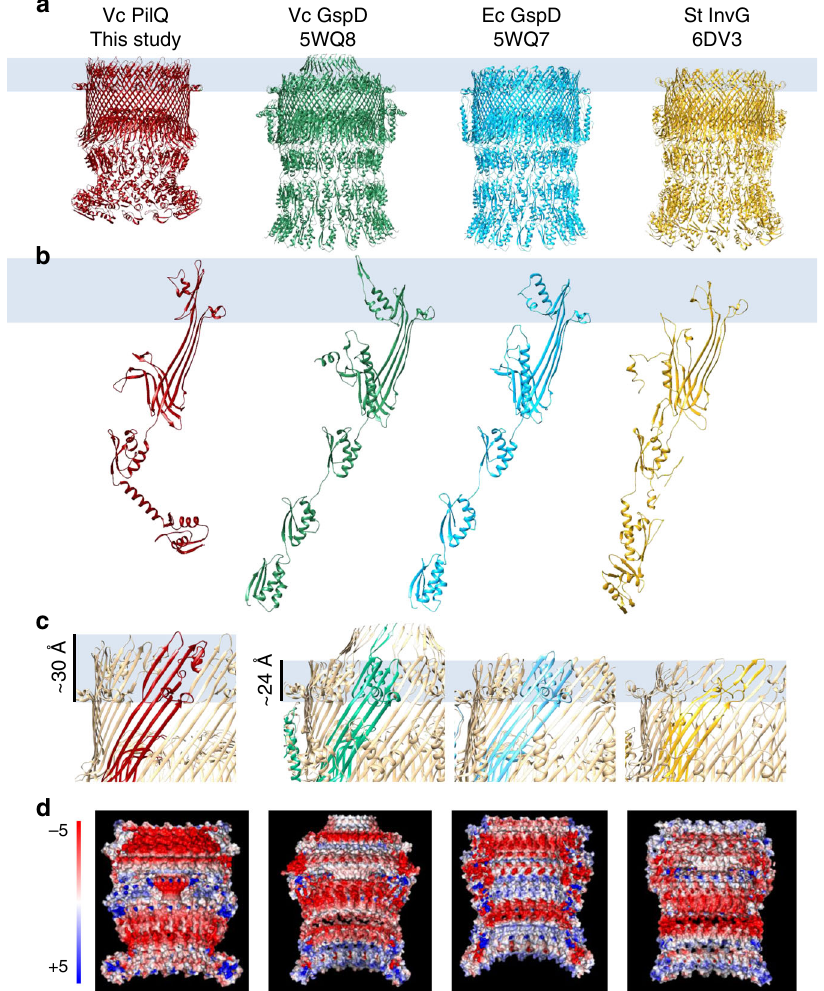
Fig. 2 Comparison of VcPilQ to T2SS and T3SS secretins. The structures of VcPilQ (this study, dark red), V. cholerae GspD (5WQ8) (green), E. coli K12 GspD (5WQ7) (blue), and S. typhimurium InvG (6DV3) (yellow) are compared 55, 61 . The putative outer membrane location is depicted as a blue rectangle. The structures are shown as multimers ( a ) or monomers ( b ). c The multimer is shown in tan with one subunit colored. The putative outer membrane region is highlighted to show that VcPilQ (left, red) has a ~30 Å membrane spanning distance, while VcGspD, EcGspD, and StInvG have about a 24 Å membrane spanning distance. d Adaptive Poisson – Boltzmann solver was used to calculate the electrostatic potential calculation of each secretin in PyMol 142 . The inner cavity of each secretin is shown. The scale varies from − 5 (red) to + 5 (blue) in units of K b T / e c